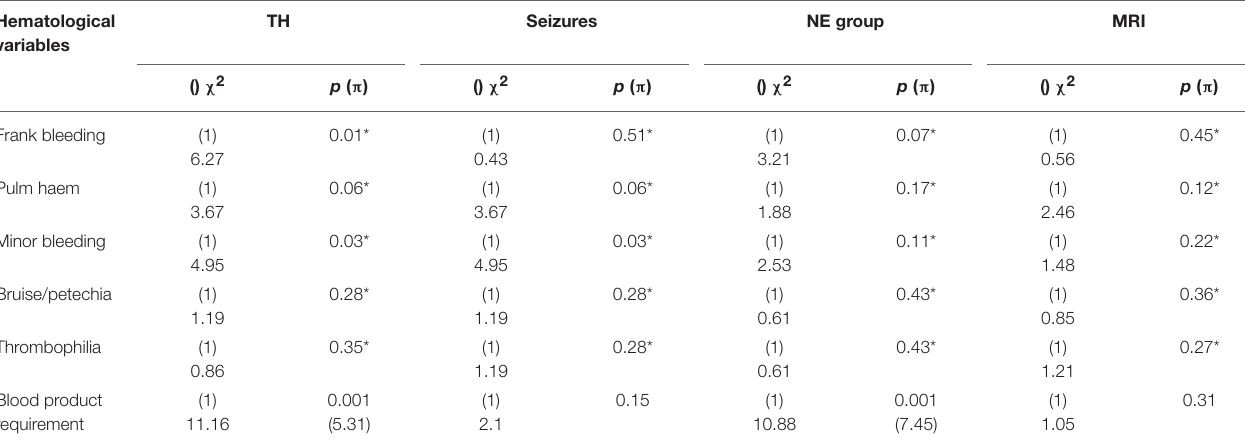
TABLE 2 | Relationship between hematological and short-term outcome variables in NE. Hematological TH variables